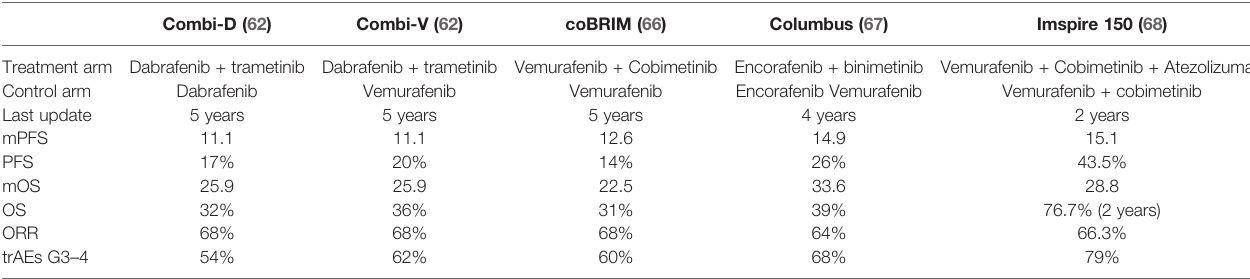
TABLE 4 | Last results of Combi-D, Combi-V, CoBRIM, Columbus and Imspire 150 trial. Combi-D